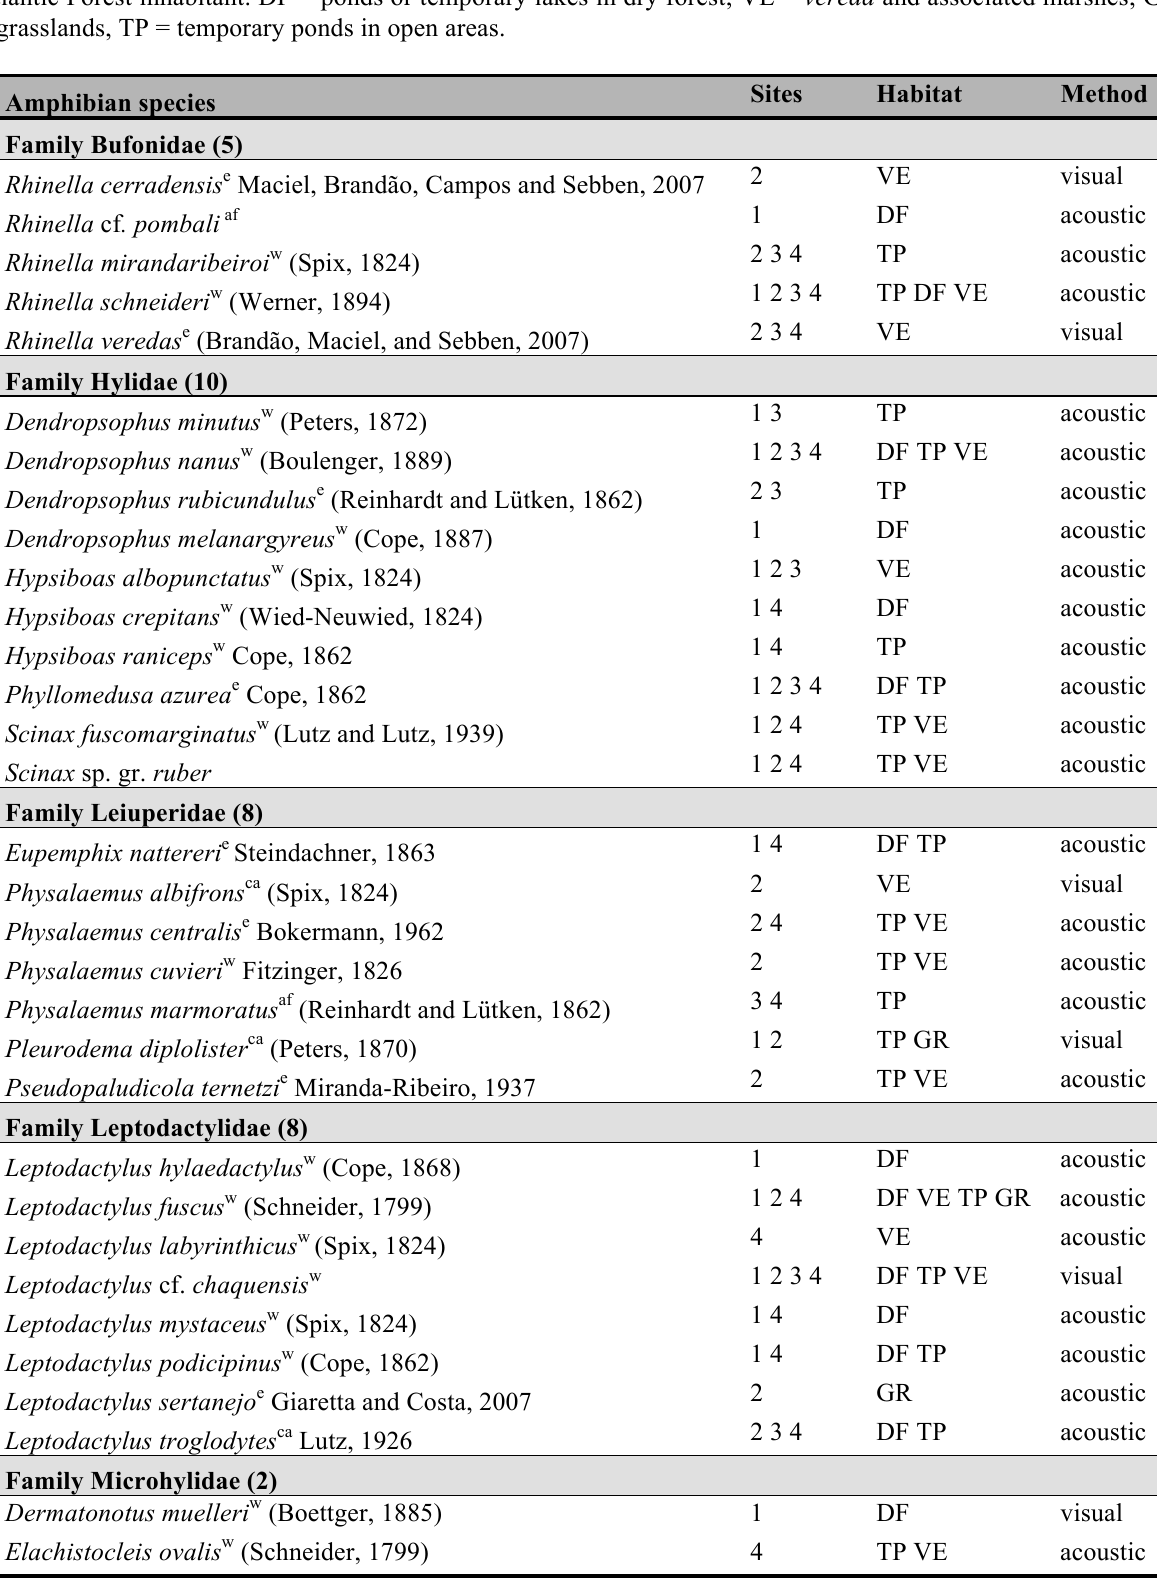
Table 1. List of species sampled from São Desidério with sites where each was found, collecting method and habitat type. e = Cerrado endemic; w = widespread; ca = Cerrado and Caatinga inhabitant; af = Cerrado and Atlantic Forest inhabitant. DF = ponds or temporary lakes in dry forest; VE = vereda and associated marshes; GR = grasslands, TP = temporary ponds in open